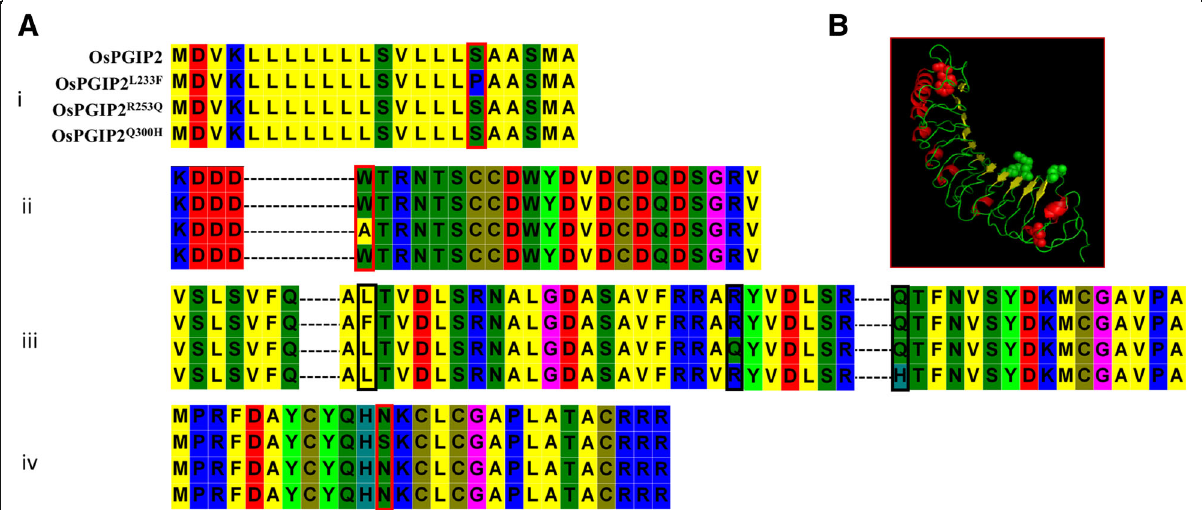
Fig. 4 Substituted and mismatched amino acids in wild-type OsPGIP2 and mutated variants OsPGIP2 L233F , OsPGIP2 R253Q , and OsPGIP Q300H . a , Amino acid sequence of OsPGIP2, OsPGIP2 L233F , OsPGIP2 R253Q , and OsPGIP Q300H . (i) Signal peptide; (ii), predicted N-terminus of mature proteins; (iii) LRR motifs; and (iv), C-terminus. Black and red rectangles represent targeted and unanticipated mutations, respectively. b , Cartoon model of OsPGIP2. Red and green balls denote mismatched and substituted amino acids, respectively.